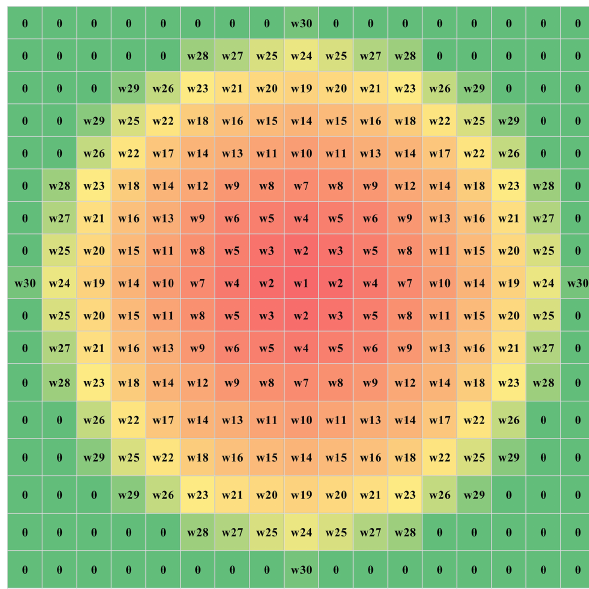
Figure 1. Weight template for a circular local window with a half- window size of nine grids in which w1 to w30 represent different weight classes that decrease with distances and 0 indicates that the grid is weighted as 0. Gradient colors ranging from red to green are used to distinguish the weight classes for grid